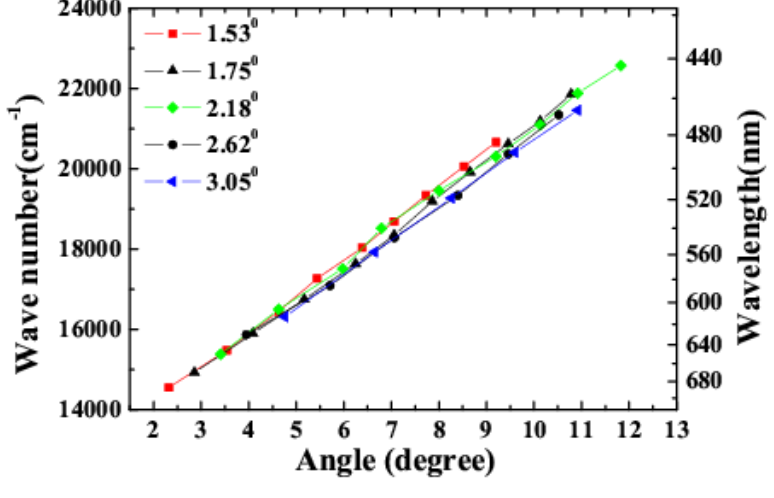
Figure 21. Relationship between the center wavenumber (wavelength) of different sidebands and the emitting angle of different sidebands. The crossing angle between the two input beams of which direction is normal to the crystal surface is 1.53º, 1.75º, 2.18º, 2.62º, and 3.05º